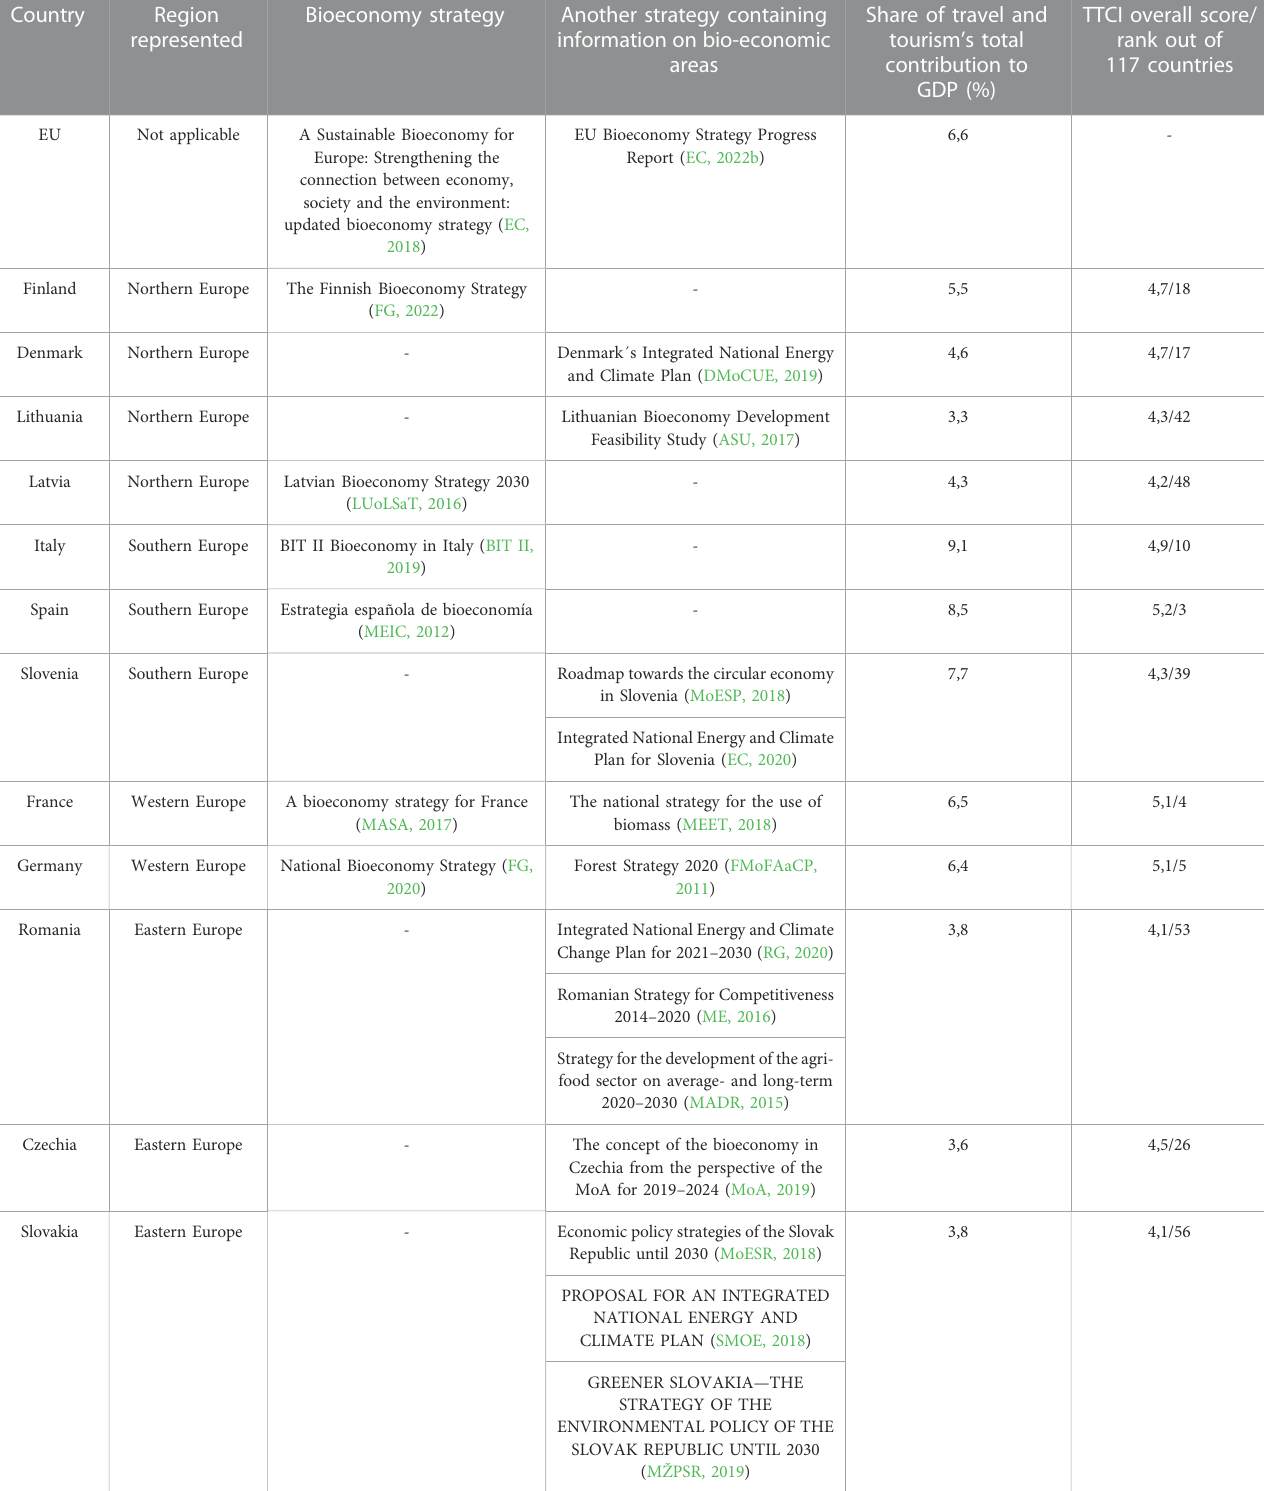
TABLE 1 Studied documents in selected countries and EU regions and their tourism position.